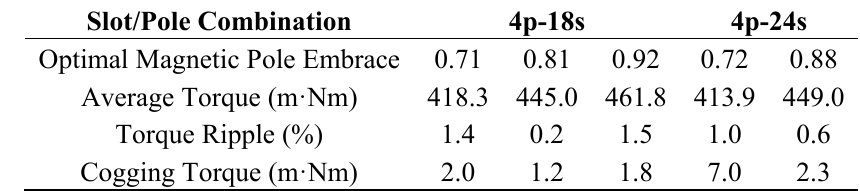
Table 6. The torque characteristics at simulated optimal magnetic-pole